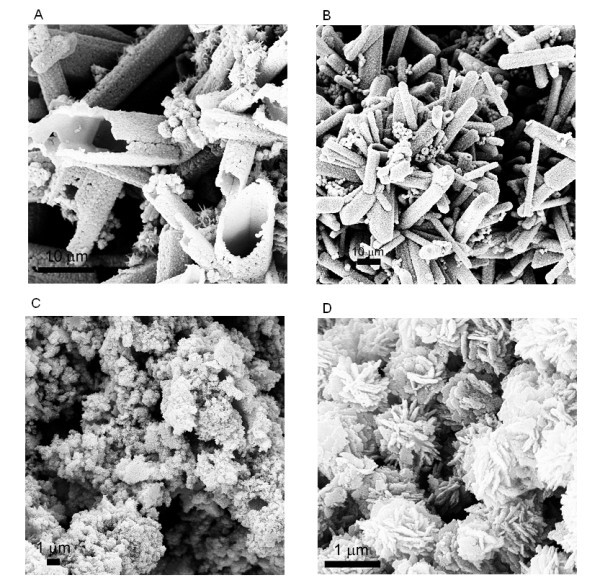
FESEM images of ZnO nanostructures. Obtained from the precipitation reaction between Zn(CH3COO)2·2H2O and (NH4)2CO3 with the  ratio at (A) 2.4:1.0, (B) 2.0:1.0, (C) 1.6:1.0, and (D) 1.0:1.0.